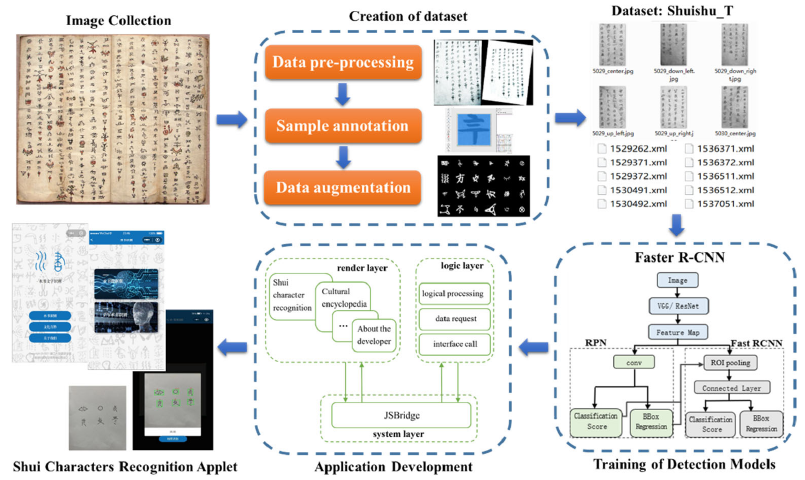
Figure 9. Development process of the Shui characters recognition applet.